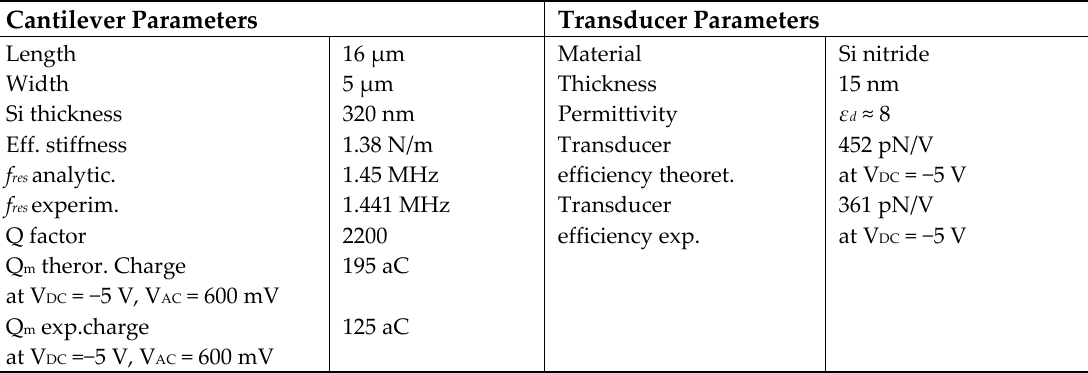
Table 1. Summary of the device and dielectric transducer